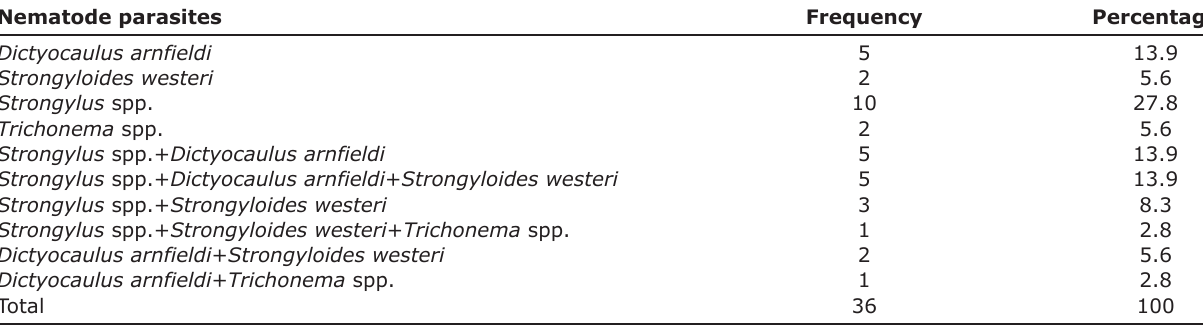
Table-3: Relative proportions of nematode species in infected slaughtered donkeys. Nematode